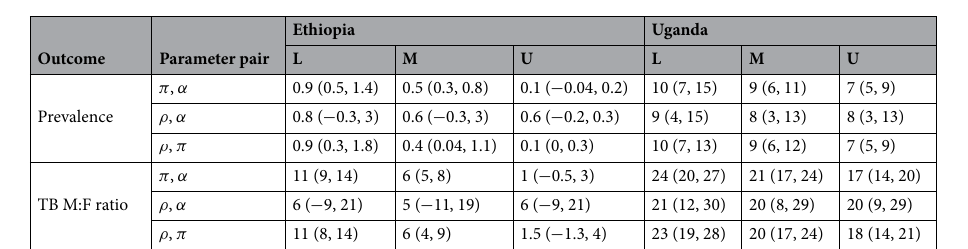
Table 3. Sensitivity analysis of percentage reduction in TB prevalence and M:F ratios sampling from restricted regions of the posterior. ‘L’, ‘M’, and ‘U’ correspond to different elliptical regions shown top-right in Fig. 4. ( ρ —assortativity, π —differential detection, α —differential